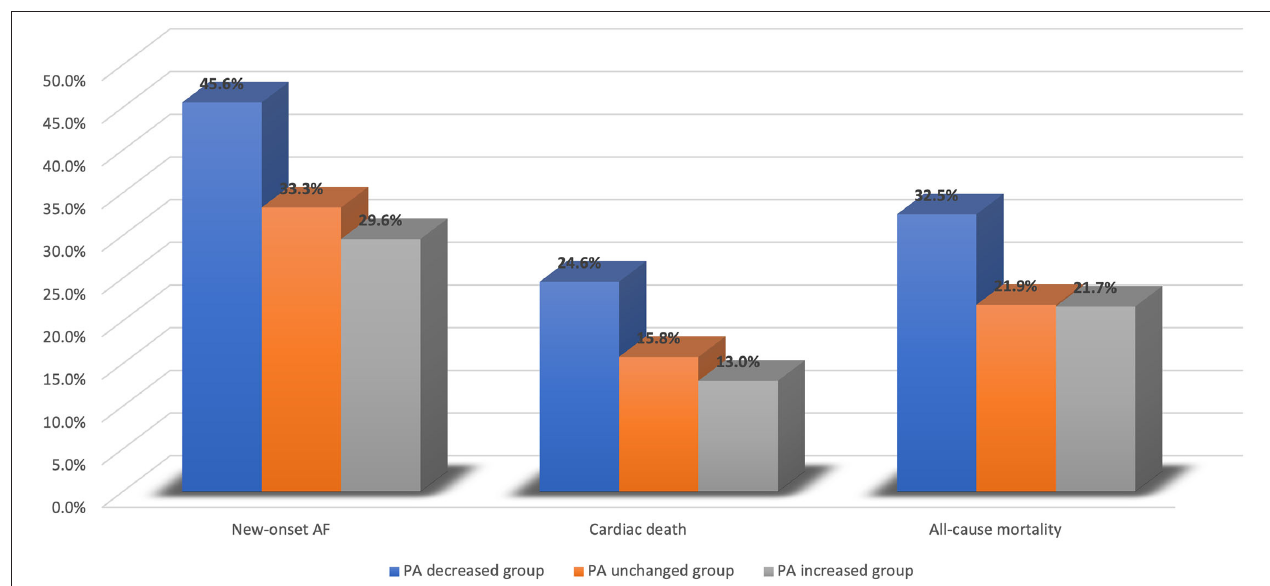
FIGURE 1 | Clinical outcomes across PA decreased group, PA unchanged group, and PA increased group. AF, atrial fibrillation; PA, physical